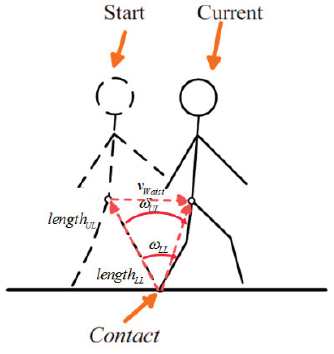
Figure 11. Movement of waist could be assumed to pivot motion when a foot is connected to